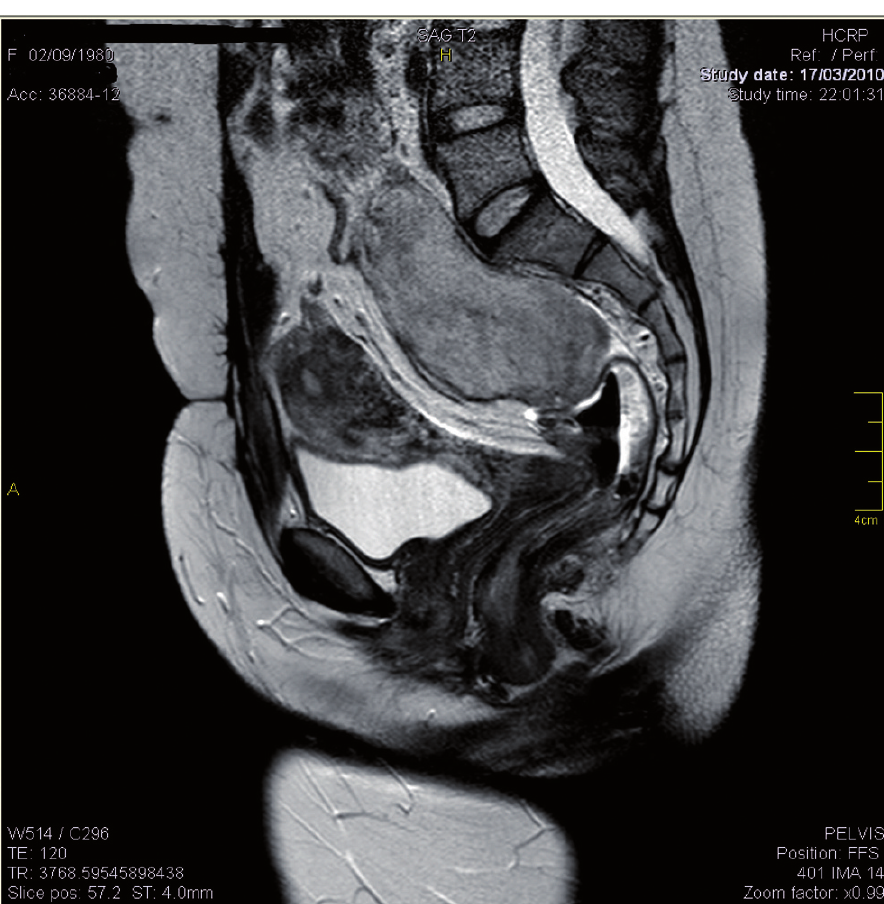
Figure 2 - Magnetic resonance imaging (MRI) showing another mass in the region anterior to